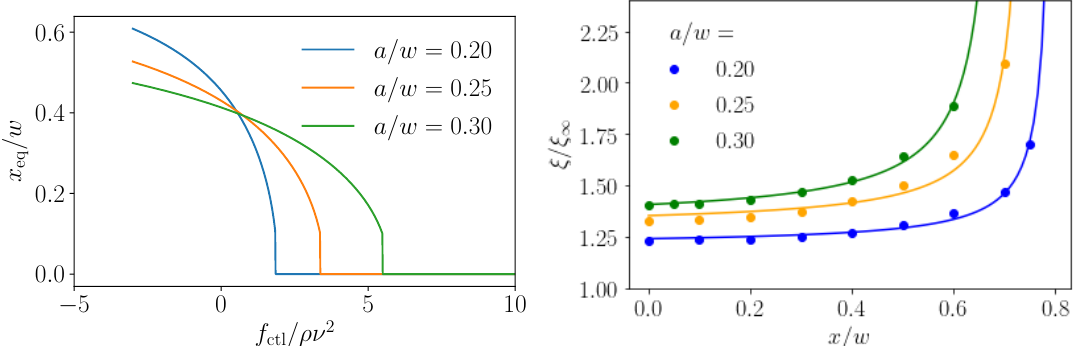
Figure 3. ( Left ): stable equilibrium positions (fixed points) as a function of control force for different particle radii a / w . They were determined using the analytical fits to the relevant lift-force profiles in Figure 2, right. ( Right ): hydrodynamic friction coefficients relative to the bulk value ξ ∞ = 6 πη a plotted versus the lateral particle position for different particle radii. The solid lines are fits using Equation